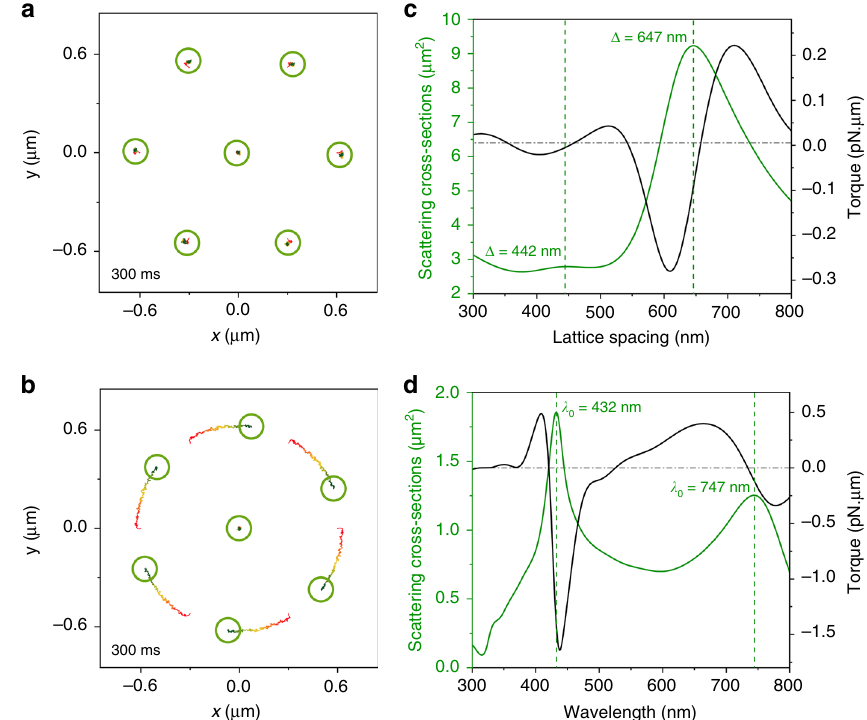
Fig. 5 Optical interactions among NPs in optical matter arrays. a GMT-Langevin dynamics simulations of a 7-NP array where NP optical interactions are turned off. b The interactions are turned on causing rotation of the array. c Scattering cross-sections and optical torque for a 12 NP optical matter array built on an equilateral trigonal lattice with variable lattice spacing, while the illumination wavelength is fi xed at 800 nm and in a medium with refractive index n = 1.33. The scattering peak at Δ = 647 nm corresponds to the 01 LP mode predicted by Eq. (1). d Scattering cross-sections and optical torque of the same array for different incident wavelengths. The lattice spacing is fi xed at 600 nm. The scattering peak at λ = 747 nm corresponds to the 01 LP mode while the peak at λ = 432 nm corresponds to the 11